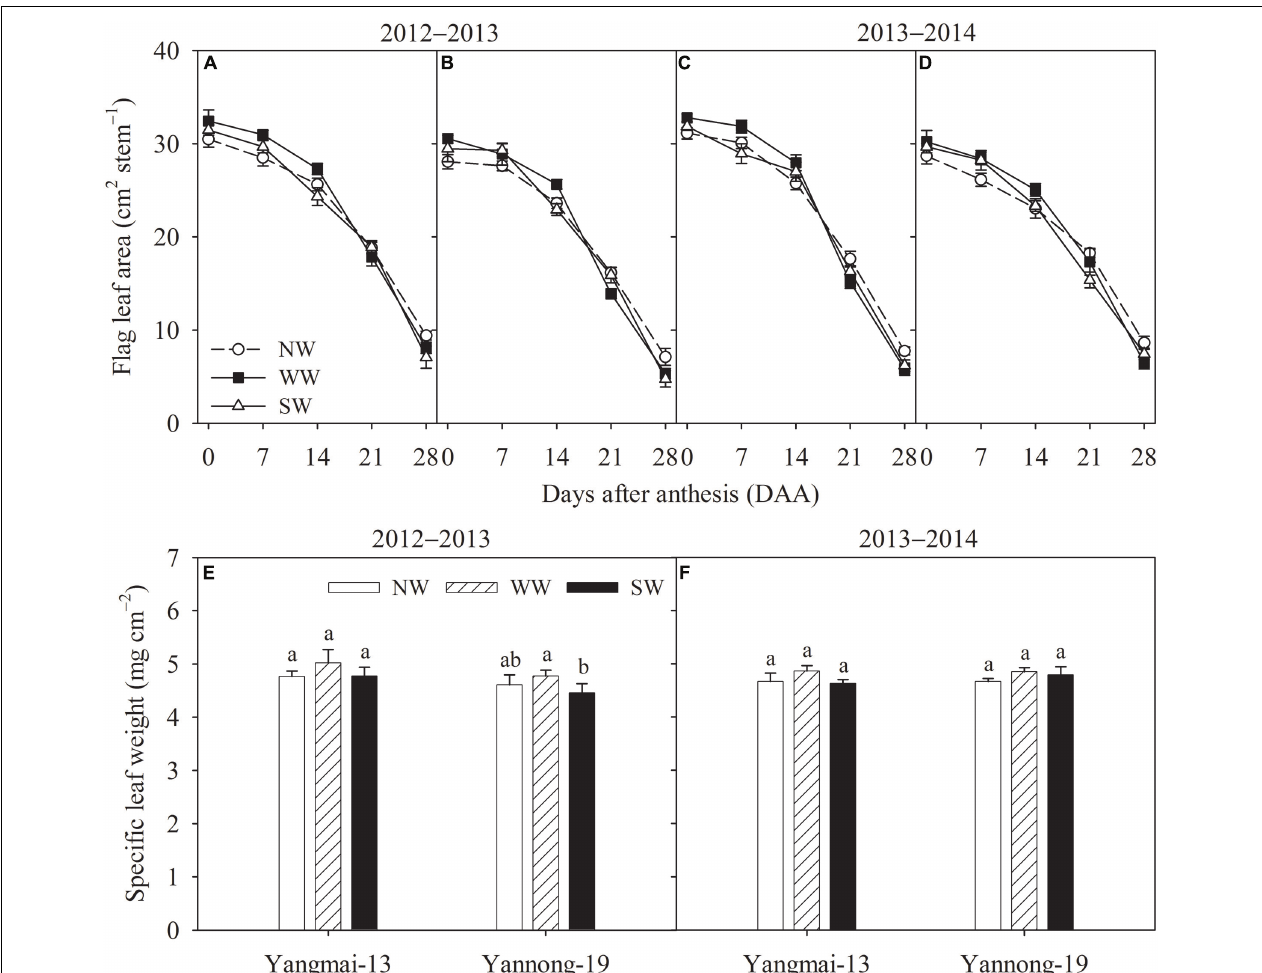
FIGURE 2 | Flag leaf area (A–D) and flag leaf specific leaf weight (E,F) of Yangmai-13 and Yannong-19 after anthesis as affected by winter (WW) and spring (SW) night-warming during 2012–2013 and 2013–2014. NW refers to the no warming control. The data are the means ± SE ( n = 3). Lowercase letters refer to significant differences between treatments ( P < 0.05). Whiskers on the top of the bars indicate the standard error.